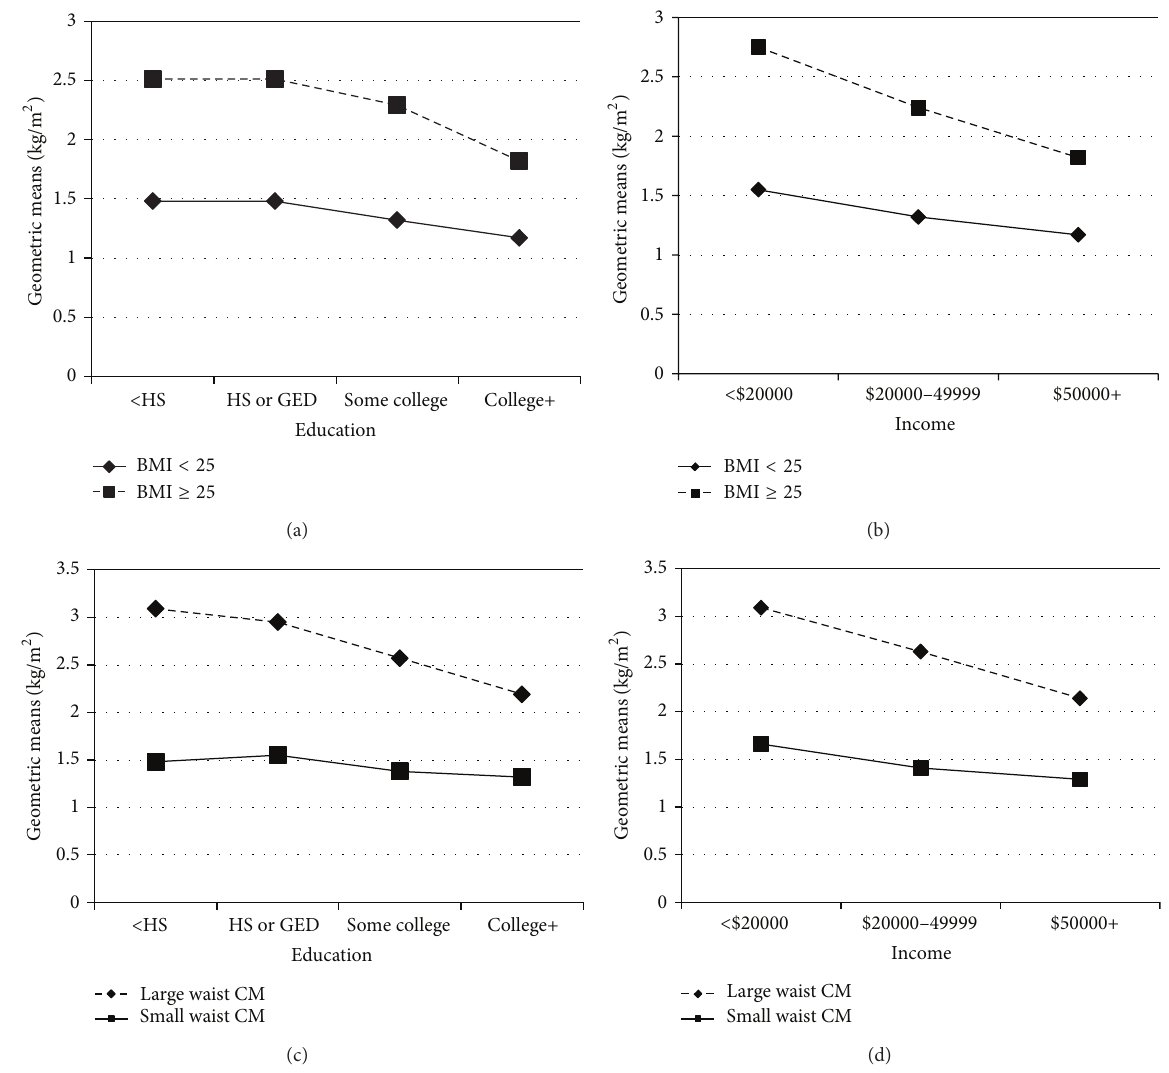
Figure 1: Geometric means of BMI and waist circumference by education and income strata.